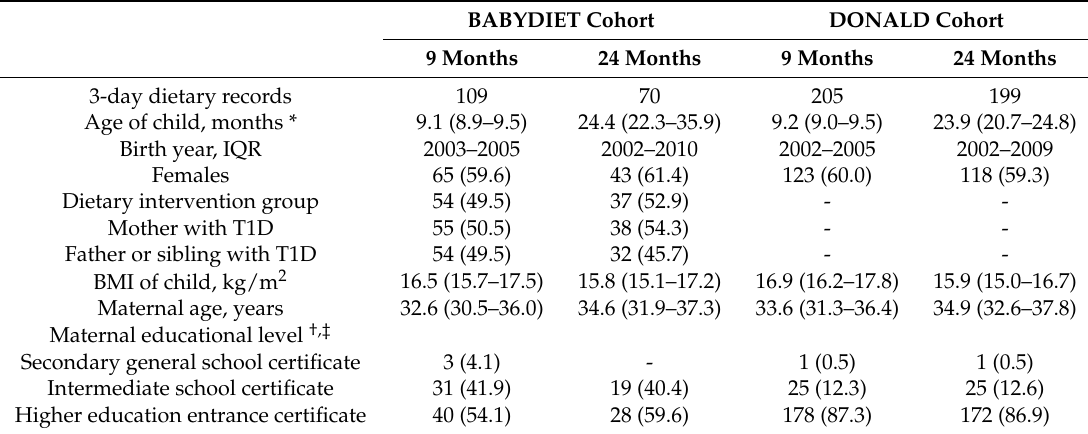
Table 1. Characteristics of the study cohorts.